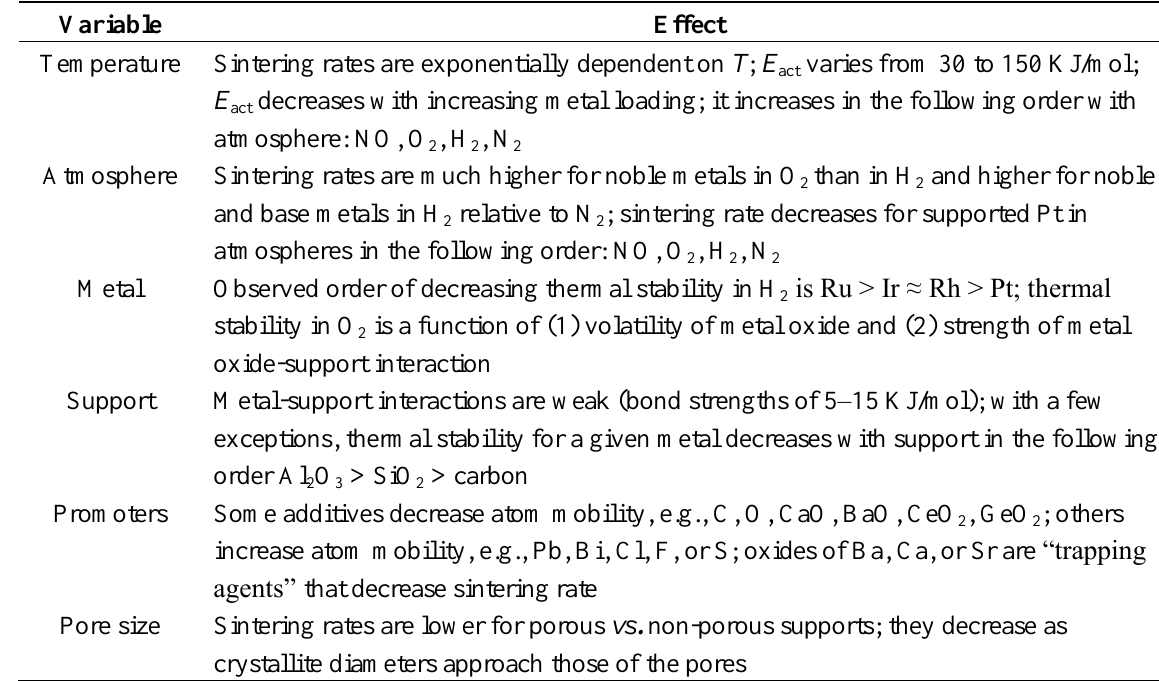
Table 6. Effect factors in catalyst sintering